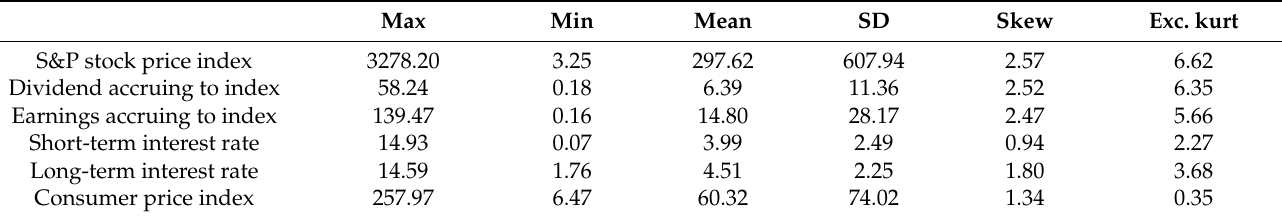
Table 1. U.S. market data